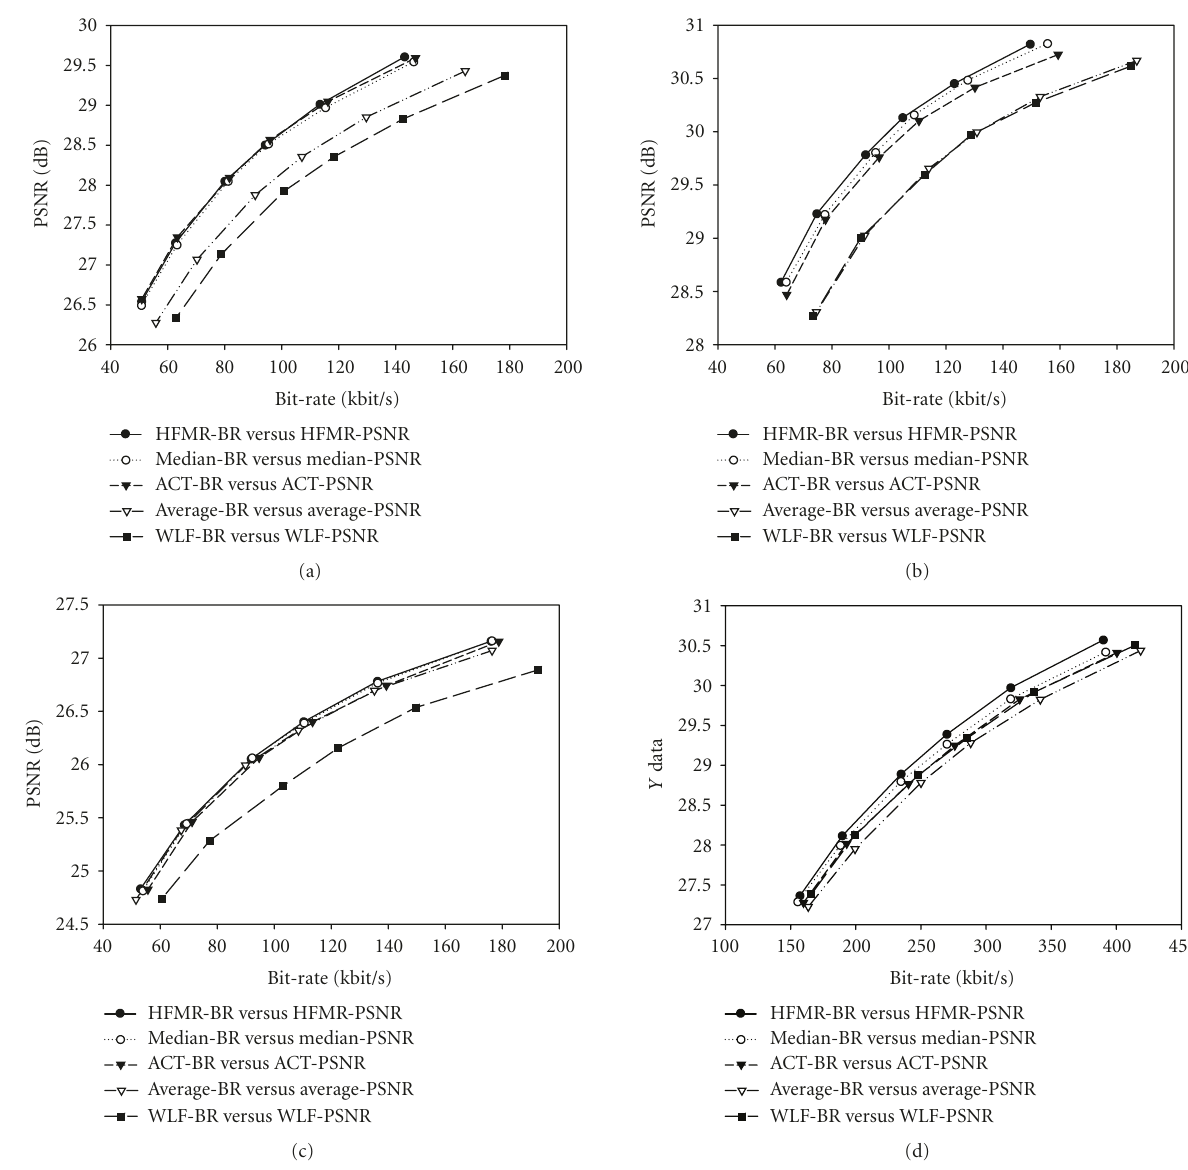
Figure 16: The R-D curves for di ff erent FMR algorithm. (a) Foreman. (b) TableTennis. (c) Coastguard. (d) Football.